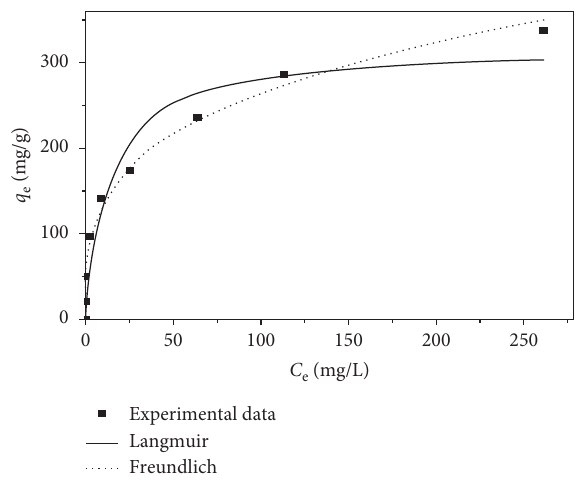
Figure 6: Nonlinear fits of the Langmuir and Freundlich isotherms for MO adsorption onto activated carbon ( t contact � 2h; adsorbent dose � 1g/L; pH ∼ 7; T � 20 ° C). Table 3: Langmuir and Freundlich isotherm